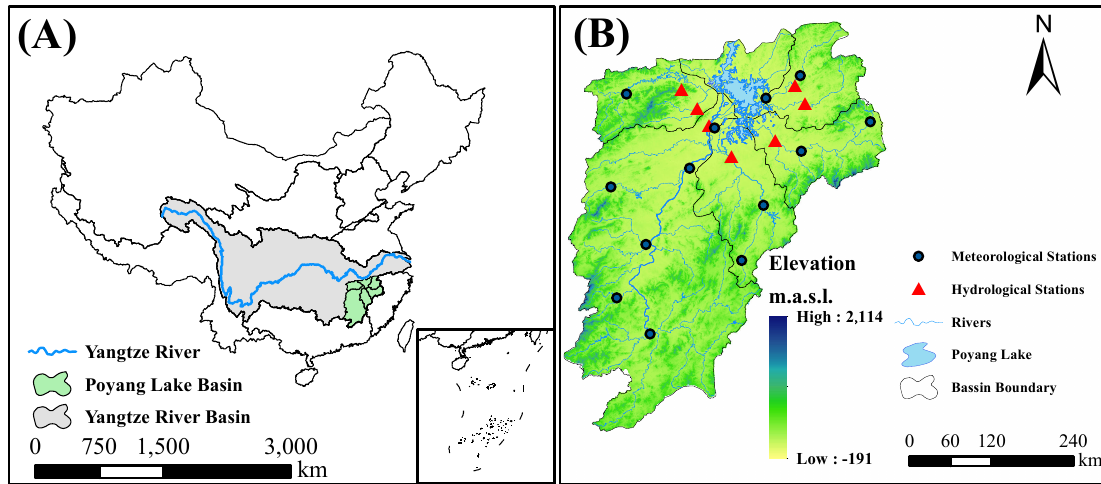
Figure 1. Topography and river networks of Poyang Lake Basin ( A ). Location of 7 hydrological stations and 13 meteorological stations are presented with red triangles and blue dots, respectively ( B